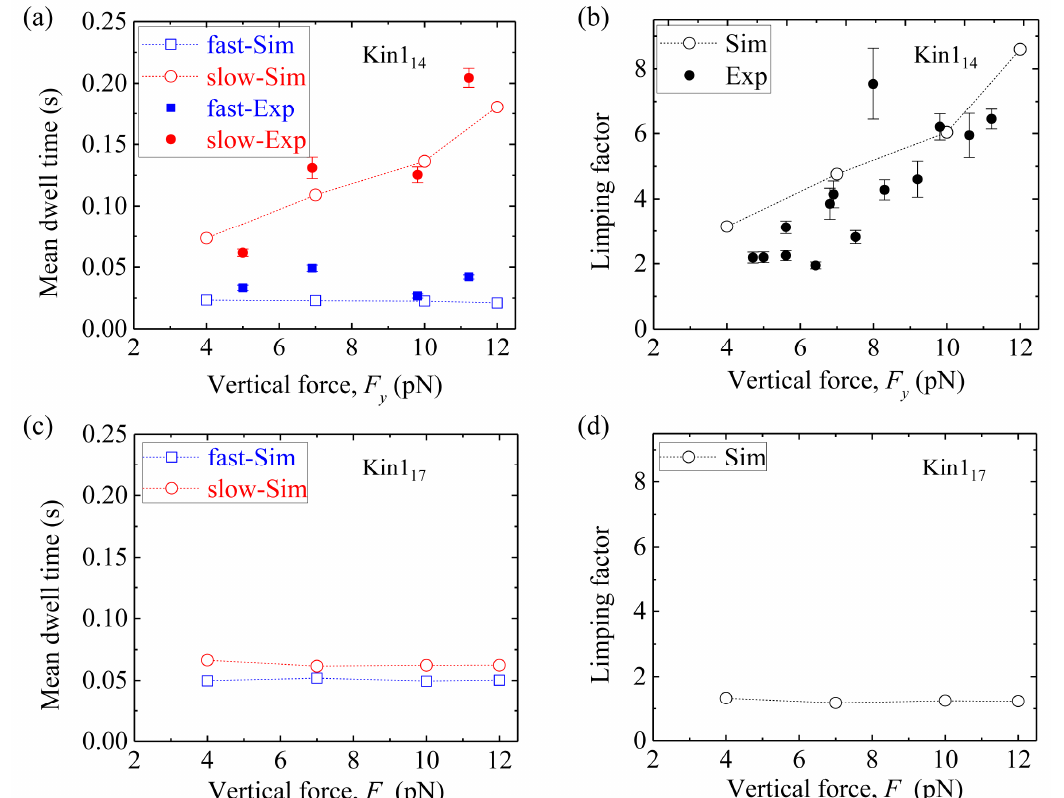
Figure 9. Limping effect of homodimeric kinesin-1 with and without extension of NLs. F x = –5 pN and δ = 0.4 nm in the simulation. ( a ) The mean dwell time of the odd (red circles) and even stepping phases (blue squares) versus F y for Kin1 14 . ( b ) Limping factor versus F y for Kin1 14 . In ( a ) and ( b ), unfilled circles and squares are simulated data, while filled circles and squares are experimental data taken from Asbury et al. [49] and Fehr et al. [50]. ( c ) The mean dwell time of the odd (red circles) and even stepping phases (blue squares) versus F y for Kin1 17 . ( d ) Limping factor versus vertical force F y for Kin1 17 .